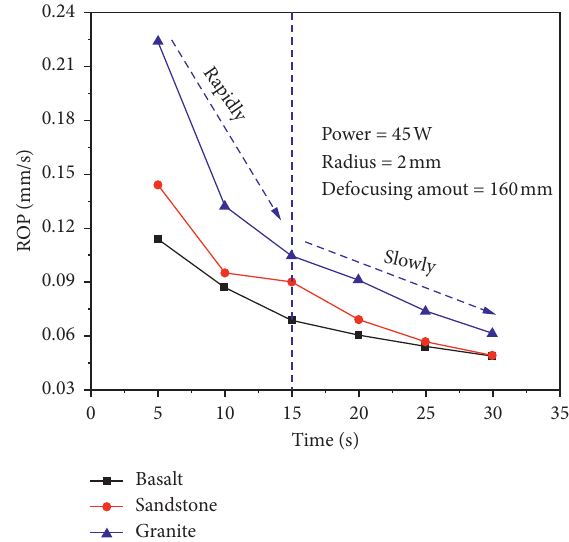
Figure 10: Effect of the laser irradiation time on ROP (rate of penetration) of laser